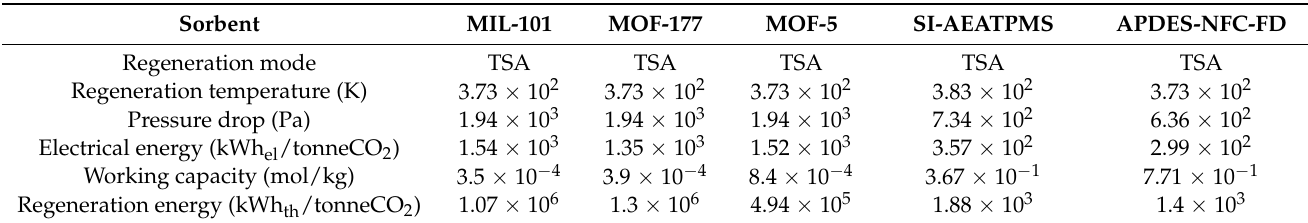
Table 11. Energy consumptions for different adsorbent